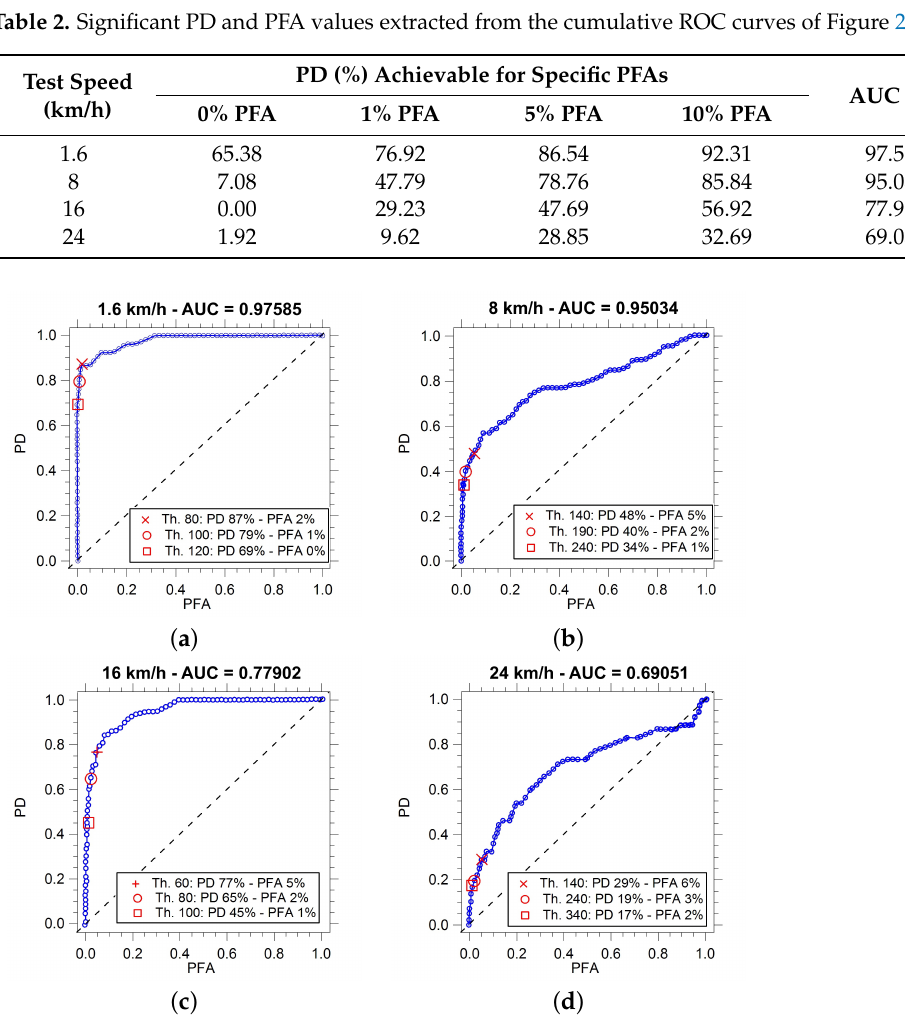
Figure 23. Cumulative ROC curves for runs executed at four different speeds: ( a ) 1.6 km/h; ( b ) 8 km/h; ( c ) 16 km/h; ( d ) 24 km/h. The results associated with three different values of the detection threshold are identified by specific